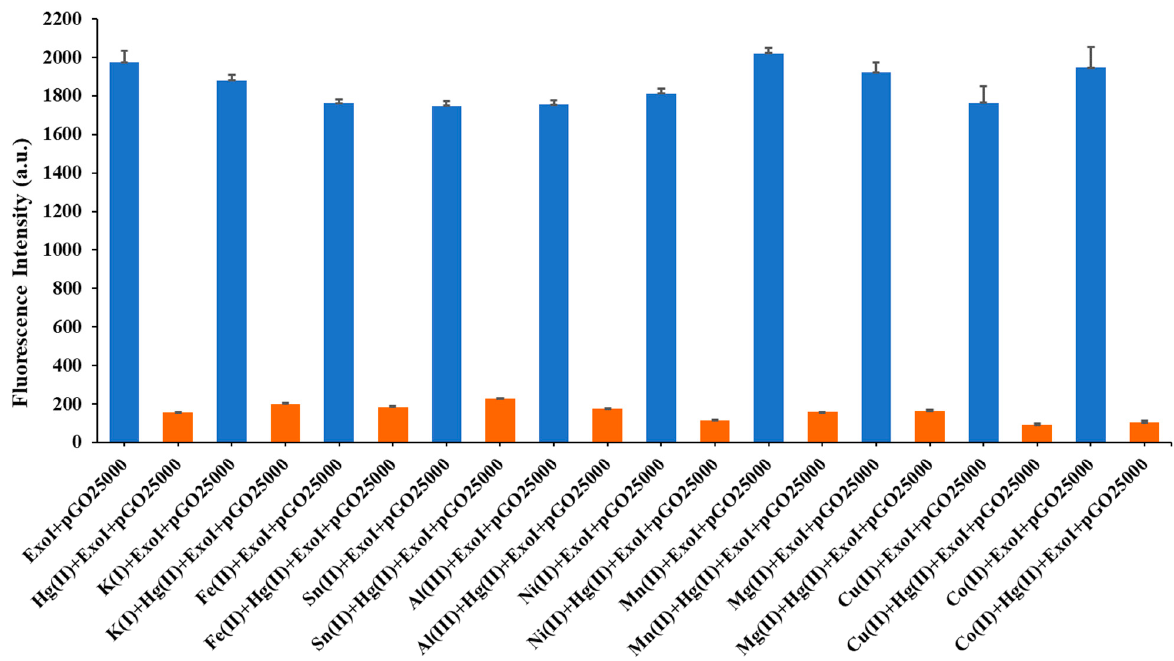
Figure 6. Selectivity of Hg 2+ detection by the FAM–ssDNA probe. The fluorescence intensities of the Exo I (2 U)/pGO25000 (0.1 µ g/mL)-assisted FAM–ssDNA probes were recorded without or with